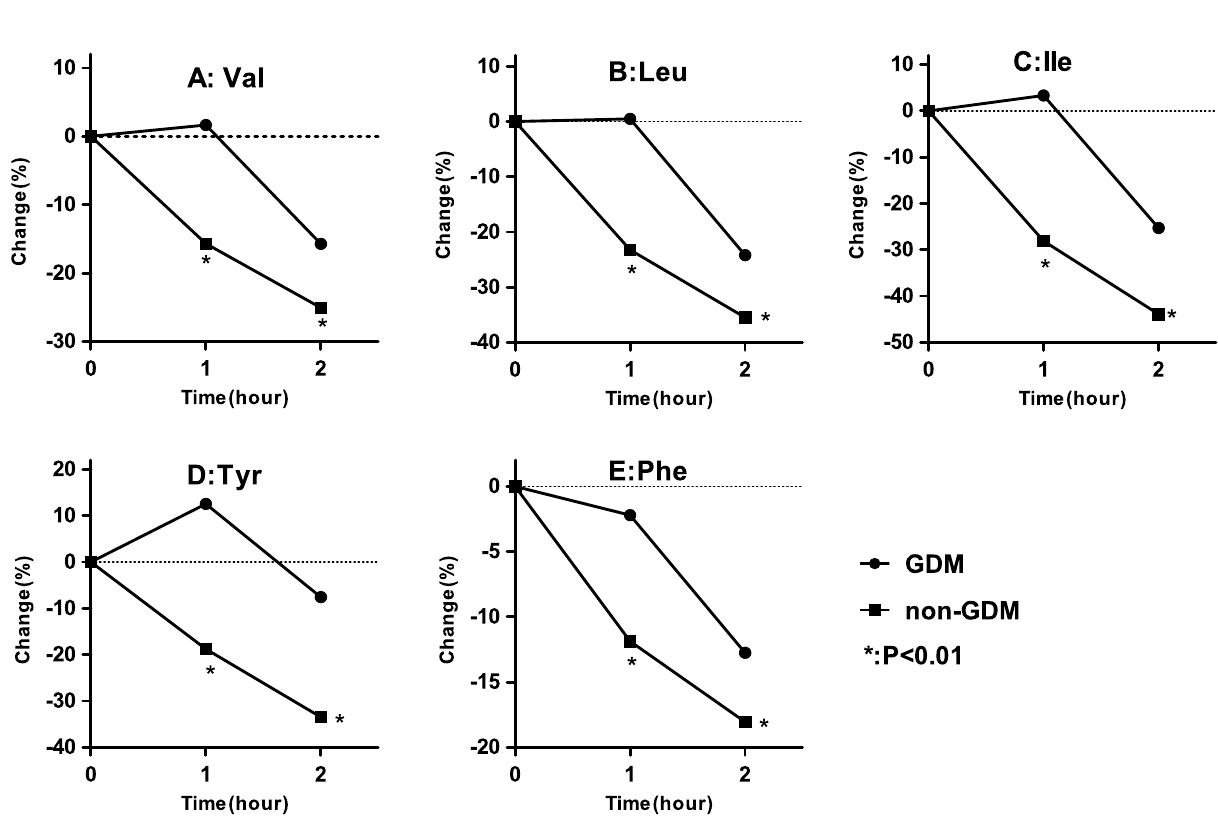
Figure 2. Percent changes of amino acid between the gestational diabetes mellitus (GDM) and non-GDM groups. The dots denoted mean percent change. Percent change was defined as the absolute change in relative to baseline. ( A ) Val. ( B ) Leu. ( C ) Ile. ( D ) Tyr. E Phe. *P < 0.01, compared percent changes of amino acid at corresponding time point between GDM and non-GDM using student’s t